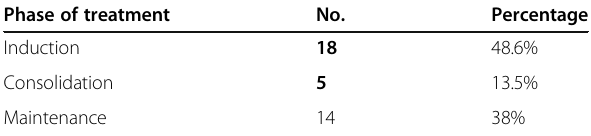
Table 1 Phase of treatment at study time Phase of